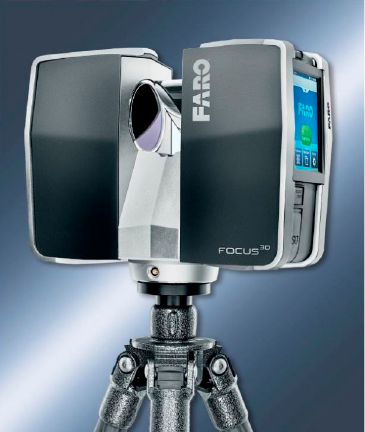
Figure 7. Faro3D X330 scanner.